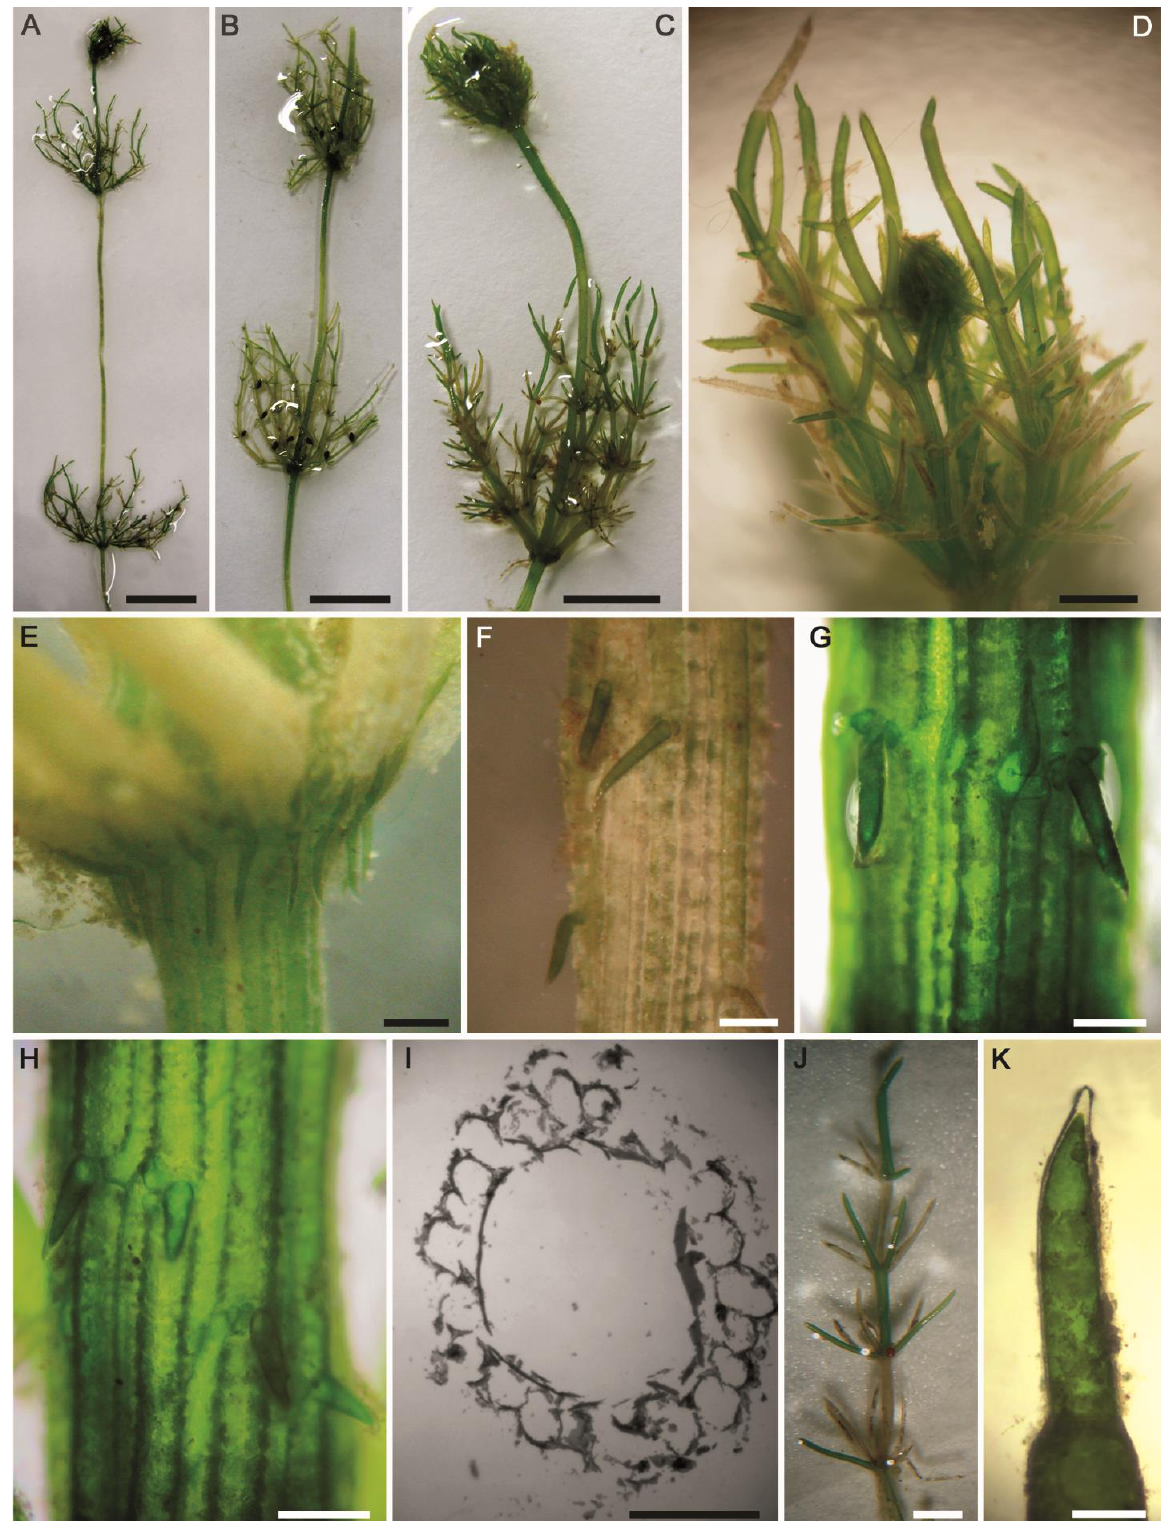
Figure 8. Morphotaxonomic features of Chara globata found in the thermal mineral desert spring ‘Ain Wazedi’ in the Siwa Oasis (the Western Desert of Egypt): ( A – C ) macroscopic habitus; ( D ) whorl of branchlets; ( E ) axial node showing stipulodes in 2 tiers; ( F – H ) axial cortex, diplo–triplostichous (slightly isostichous to distinctly tylacanthous), and spine-cells; ( I ) internode cross-section showing diplo–triplostichous cortication; ( J ) branchlet; ( K ) apex of branchlet. Scale bars: ( A , B ) = 1 cm; ( C ) = 0.5 cm; ( D , J ) = 2 mm; ( E – H ) = 400 μ m; ( K ) = 200 μ m, ( I ) = 40 μ m.